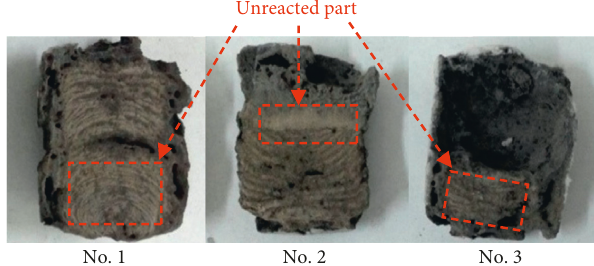
Figure 1: Incompletely reacted oxygen